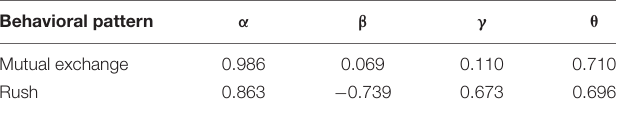
TABLE 2 | Parameter configuration of the self-concept fairness model for different behavior. Behavioral